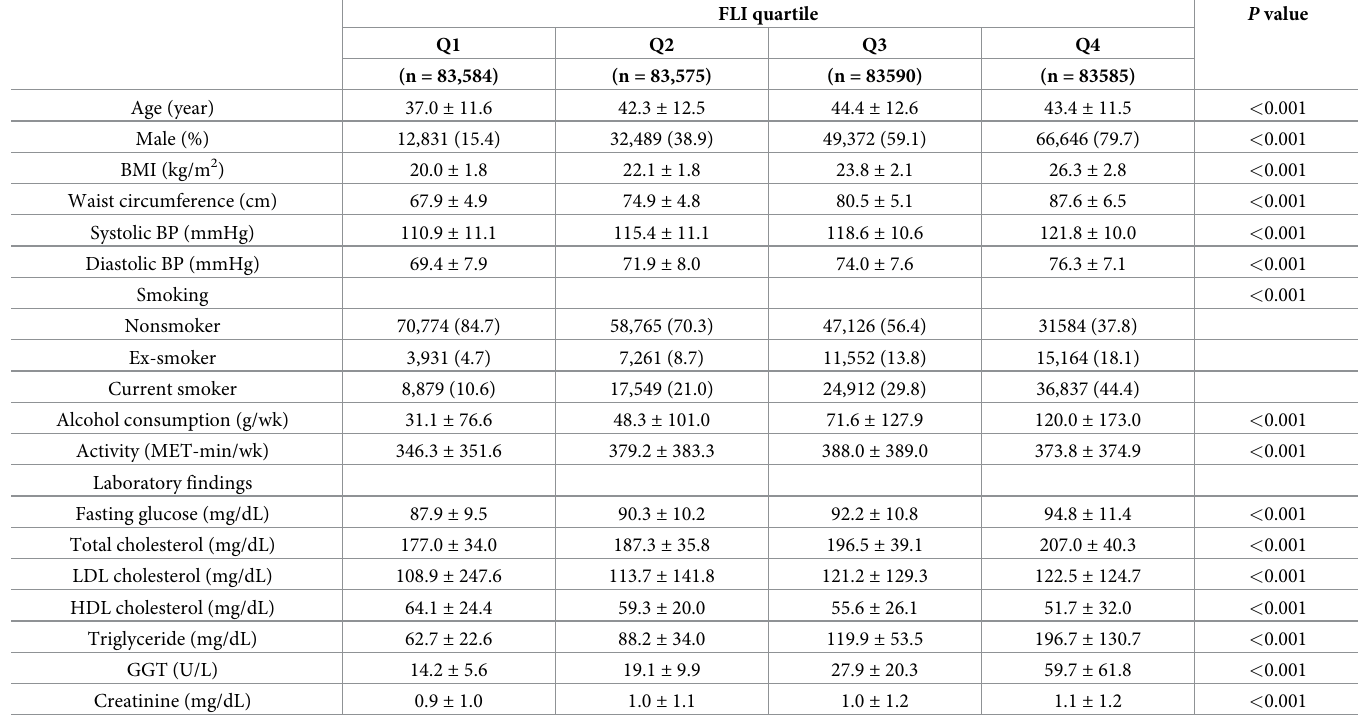
Table 1. Baseline